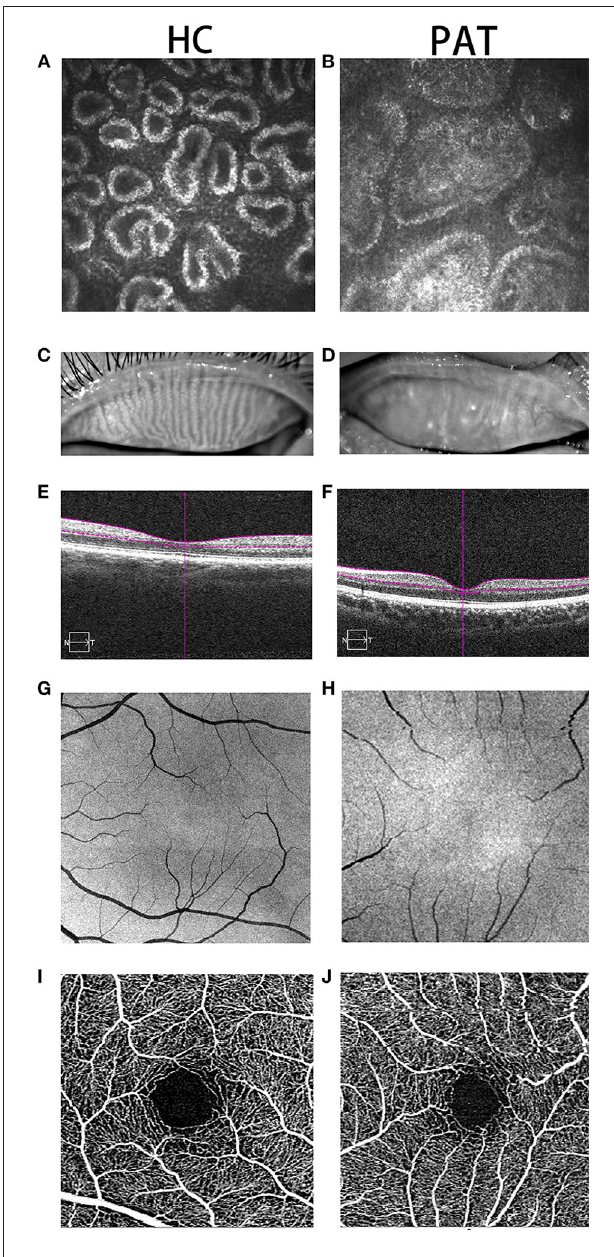
FIGURE 1 | Typical pictures of HC and PAT groups. Two groups of MGs were photographed by corneal confocal microscope. As can be seen from (A,B) , compared with the HC group, the MG in the PAT group was significantly blocked, and gland blockage was widened at the same time. What’s more, we photographed the changes of the MGs under the naked eye in the HC group and the PAT group. From (C,D) , we can clearly observe that the MG in the HC group is clearer than that in the PAT group. Therefore, we can speculate that obesity may lead to tarsal gland blockage and degeneration. (E,F) According to the cross-sectional images of retinal thickness obtained, we can observe that the choroidal thickness in the PAT group is significantly thinner than that in the HC group. We also observed that the capillaries in the HC group (G,I) were more developed than those in the PAT group (H,J) according to the fundus vascular images we obtained, which showed that obesity may reduce the thickness of choroid and fundus blood supply, and may further cause fundus lesions. HC, healthy control; PAT, MGD patient in SO population; MG, meibomian